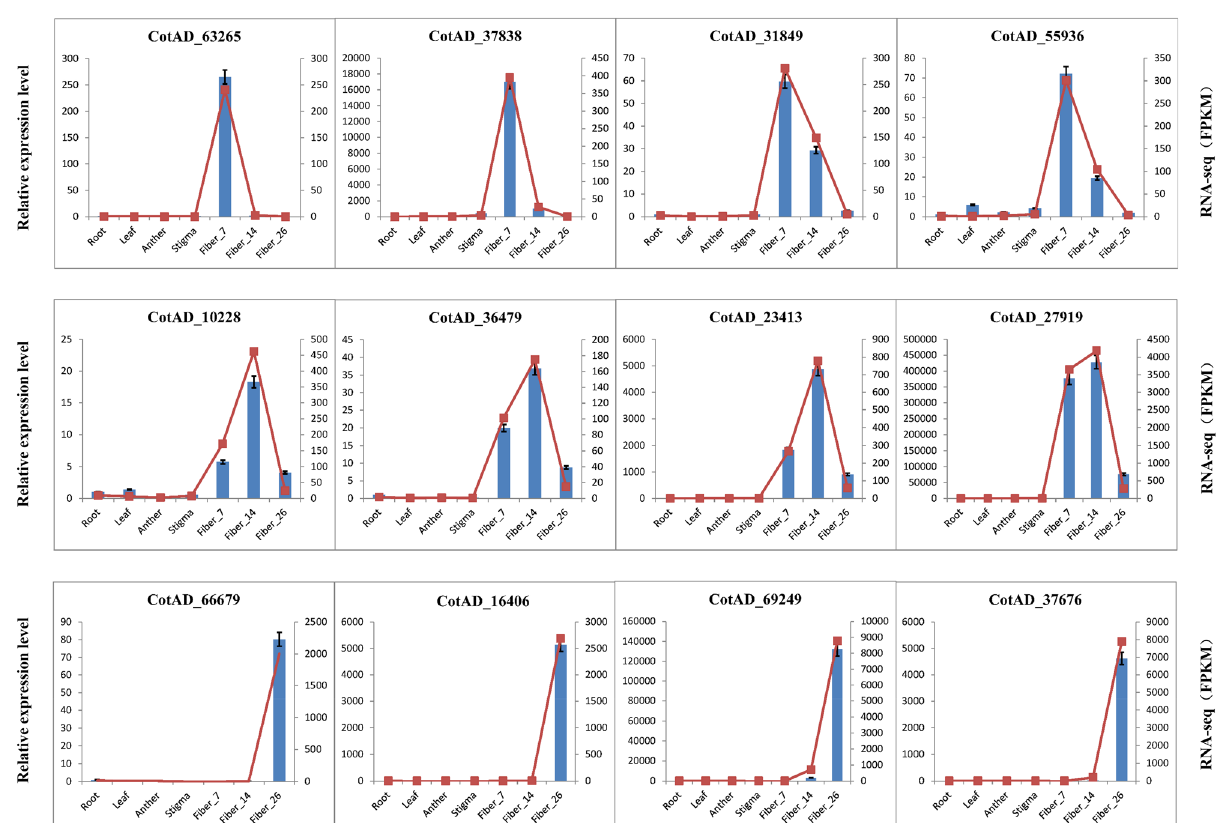
Figure 10. Validation of RNA-seq data by qRT-PCR. Root root, Leaf leaf, Anther anther, Stigma stigma, Fiber_7 7 DPA fiber, Fiber_14 14 DPA fiber, Fiber_26 26 DPA fiber; columns represent the Zresults of qRT-PCR, and zigzag lines represent the results of transcriptome